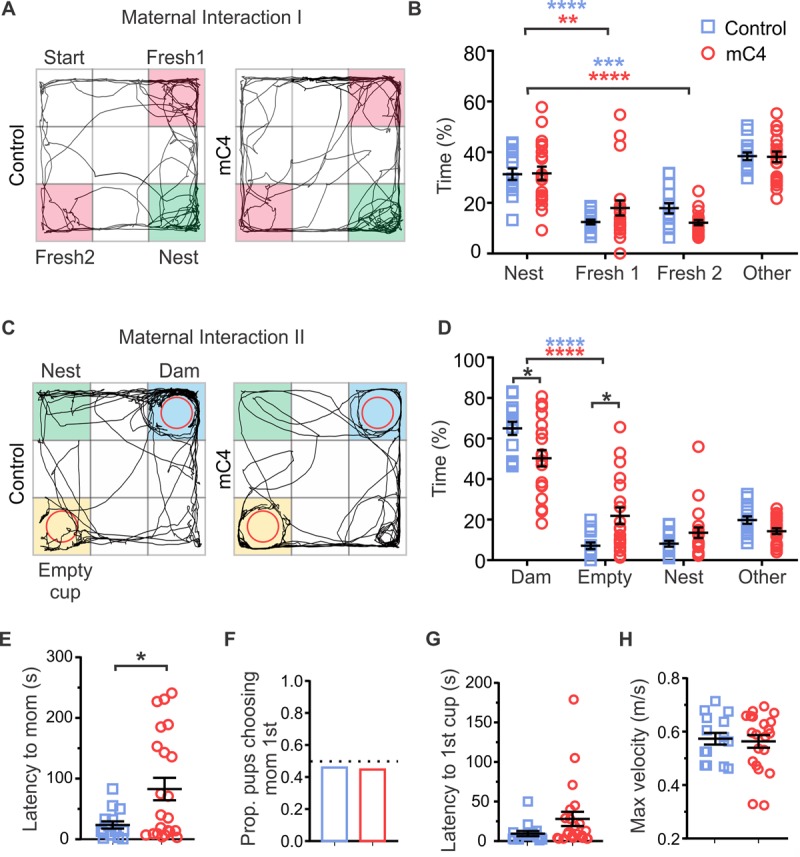
C4-dependent alterations in frontal cortical circuitry were sufficient to alter maternal–pup social interactions.(A) Representative examples of path traveled (black trace) by P18 control and mC4 pups in MI1 task. Fresh bedding corners (Fresh 1 and 2, pink) and nest bedding corner (green). (B) Control and mC4 pups spent a similar proportion of time exploring the nest and fresh corners in the MI1 task, suggesting motor and sensory skills were intact. All mice spent more time in nest bedding than in fresh bedding. **p < 0.01, ***p < 0.001, ****p < 0.0001. Two-way ANOVA and Sidak's posttest. Control versus mC4 time spent in nest: p > 0.9999. Control versus mC4 time spent in Fresh 1: p = 0.3327. Control versus mC4 time spent in Fresh 2: p = 0.3138. (C) Representative examples of path traveled (black trace) by P18 control and mC4 pups in MI2 task. Dam’s cup (dam: blue), empty cup (empty cup: yellow), nest bedding corner (nest: green). (D) mC4 pups spent less time interacting with the dam and more time near the empty cup compared to controls. Two-way ANOVA and Sidak's posttest. *p < 0.05. ****p < 0.0001. (E) mC4 mice took longer to approach the dam relative to controls (s). t test with Welch's correction. *p < 0.05. (F) Control and mC4 pups traveled to dam’s cup first about 50% of the time, suggesting first choice was random. Fisher’s exact test. p = 0.9999. (G) Latency to reach first cup (either dam or empty) was not different. t test with Welch's correction. p = 0.06. (H) Control and mC4 pups reached the same maximum velocity (m/s). t test. p = 0.77. (B, D-H) N = 15 control mice and N = 21 mC4 mice. Blue: control. Red: mC4. Mean ± SEM unless otherwise noted. For underlying data and tracking script, see https://osf.io/7em3s/?view_only=0e7ffde4ebd344dc83af83b5a605c451. mC4, mouse C4; MI1, maternal interaction 1; MI2, maternal interaction 2; P, postnatal day; Prop, proportion.